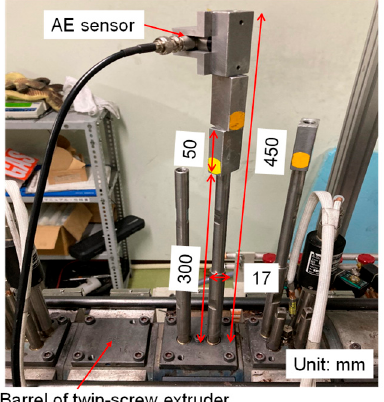
Figure 1. Image of the AE sensor, waveguide, and barrel of the twin-screw extruder.